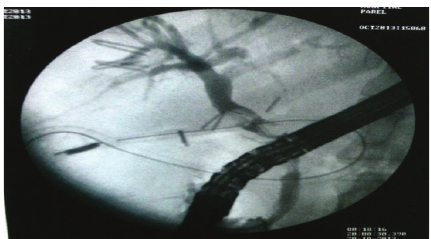
Figure 3: Postoperative ERCP showing a mid-CBD calculi and cystic duct stump blow-out. A drain (ryles tube) is seen in the region of duodenum.